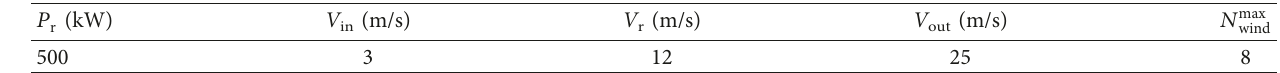
Figure 7: Solar resource data. (a) Radiation. (b) Temperature. Table 3: Wind turbine generator parameters.